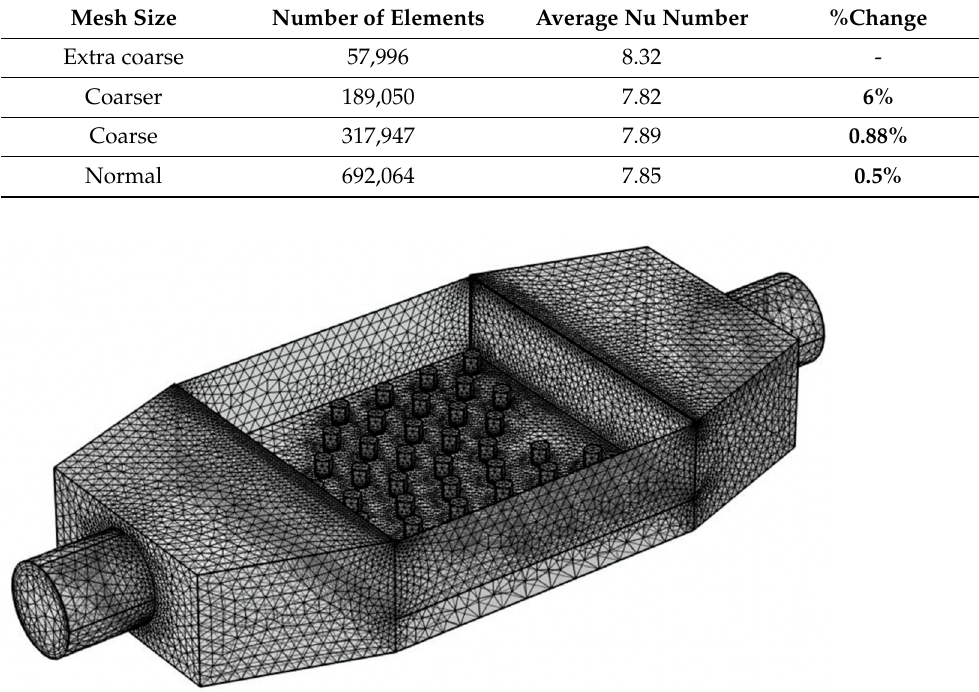
Figure 2. Mesh analysis.